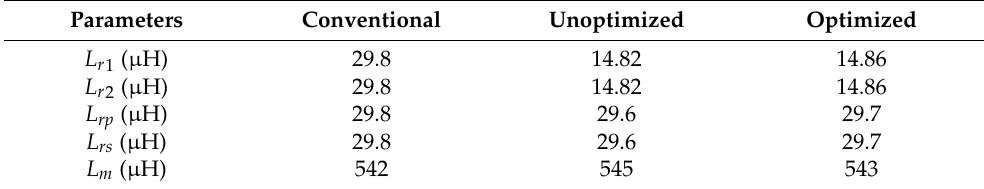
Table 4. Measured results.